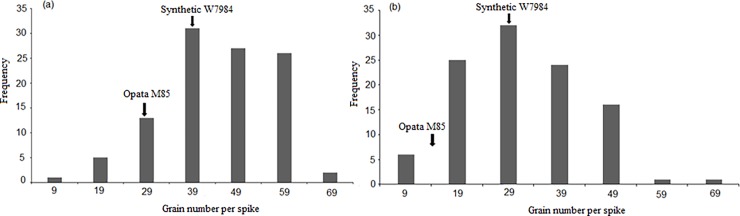
Frequency distribution of phenotypic variation for wheat grain number per spike among 105 RILs under (a) control (normal watering) and (b) water stress during meiosis. Grain number per spike for Synthetic W7984 and Opata M85 parental lines under control and water-stressed conditions are indicated by arrows. Values shown are means.